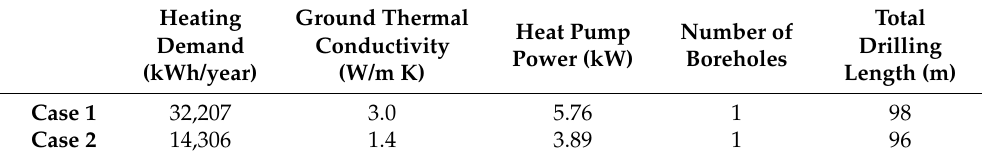
Table 4. Results obtained with GES-CAL software for the building under study in each